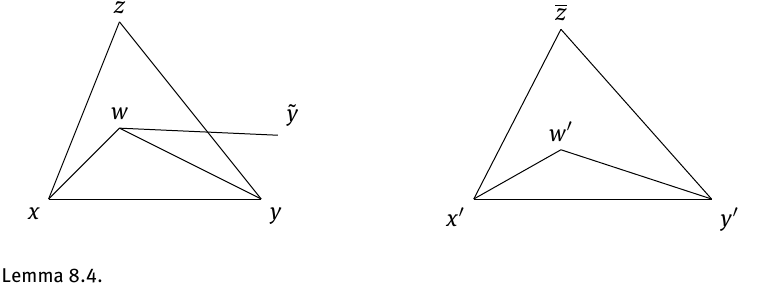
Figure 8.1: Proof of Lemma